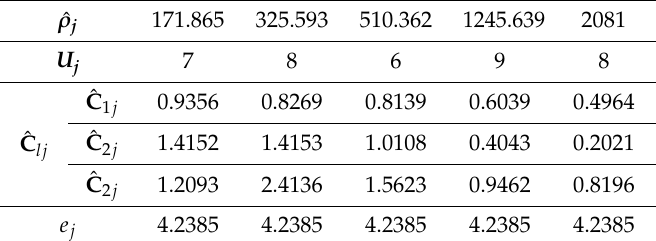
(cid:95) C , and e j for the second